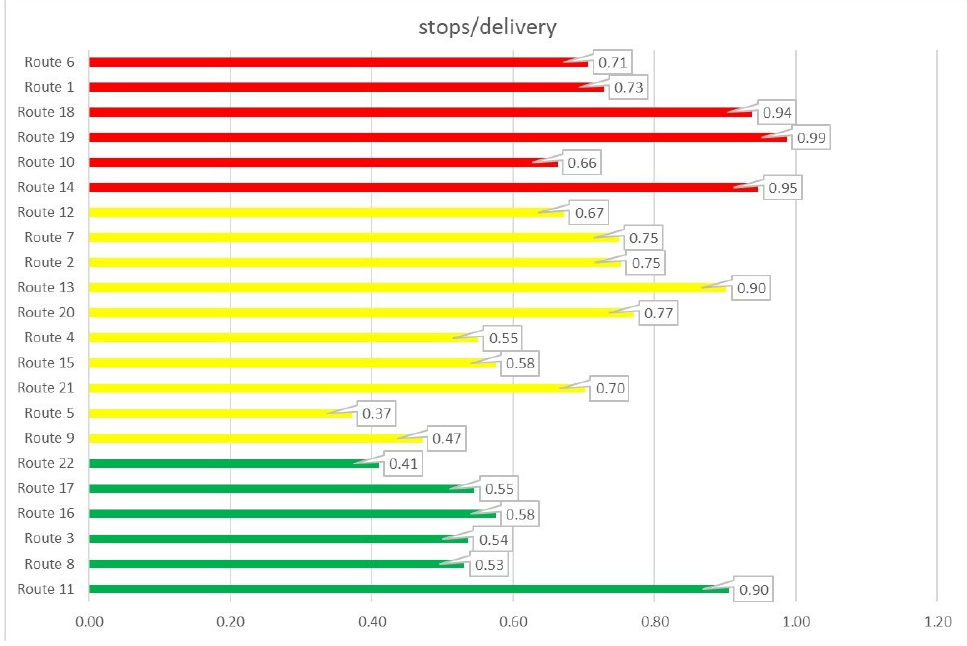
Figure 10. The beneficial of stops (number of stops per delivery) on a given route. Colors represents: green—group A, yellow—group B, red—group C Source: Own study.